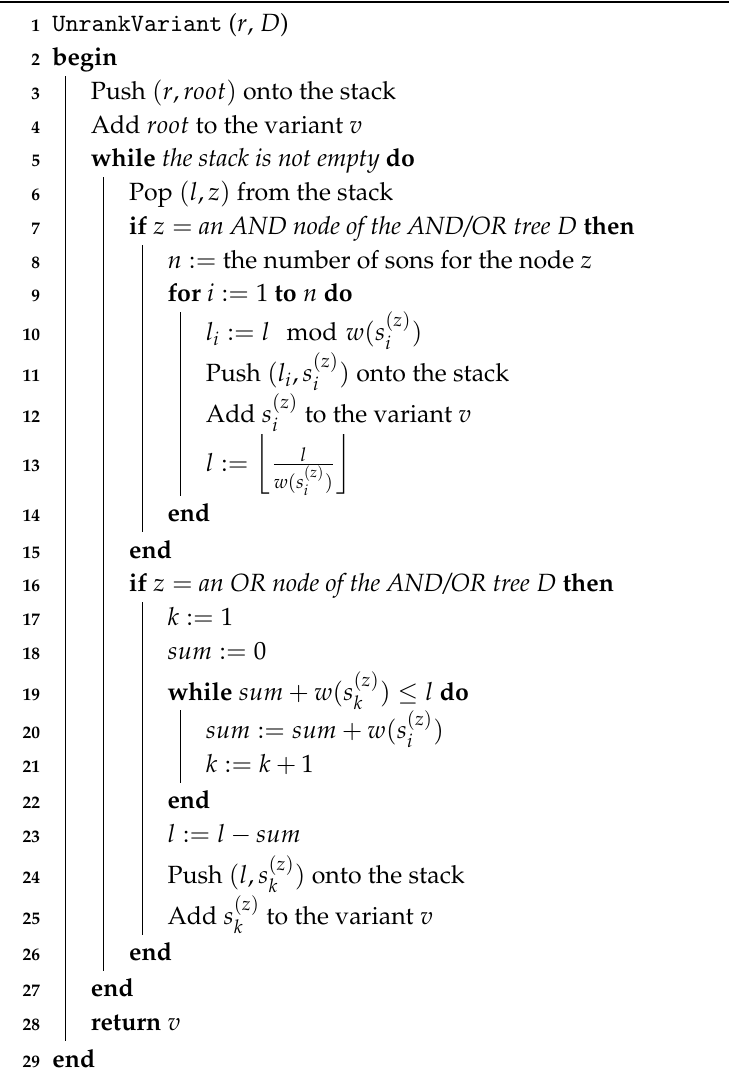
Algorithm 2: A general algorithm for unranking the variants of an AND/OR